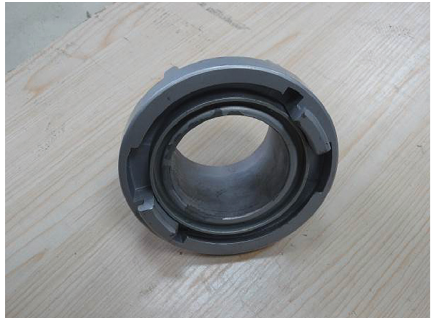
Figure 24: 1000kN microcomputer-controlled servohydraulic universal testing machine.